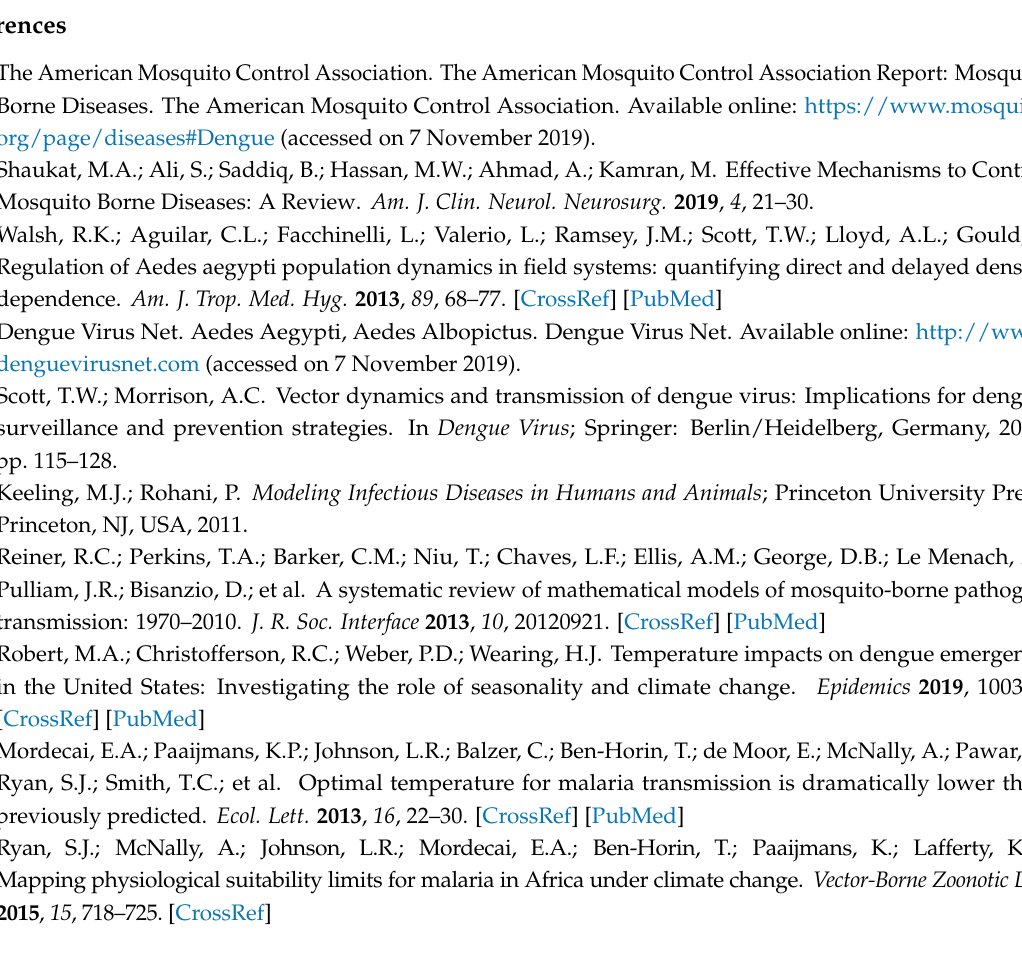
Figure A7. ( Top ) Daily adult females mosquito densities approximated using four forms, namely the sine wave V s with initial V 0 = 33 and amplitude of 0.45, the adult trait-dependent form V a , the life stage trait-dependent V l , and the dynamical density V d ; the parameter values used to solve the ode model are given in Table 1. ( Middle ) Daily temperature given by a sine function ( T 0 ( 1 + B sin ( 2 π t /365 with T 0 = 27 and B = 0.3) evaluated for 365 days used to evaluate our thermal traits incorporated into the dynamical model. ( Bottom ) Densities’ first derivatives calculated to show how each curve changes its gradient as it varies with temperature. The red line shows when the gradient is zero; positive gradient values (above the red line) mean that the density increases; and negative values of the gradient (below the red line) mean that the curve